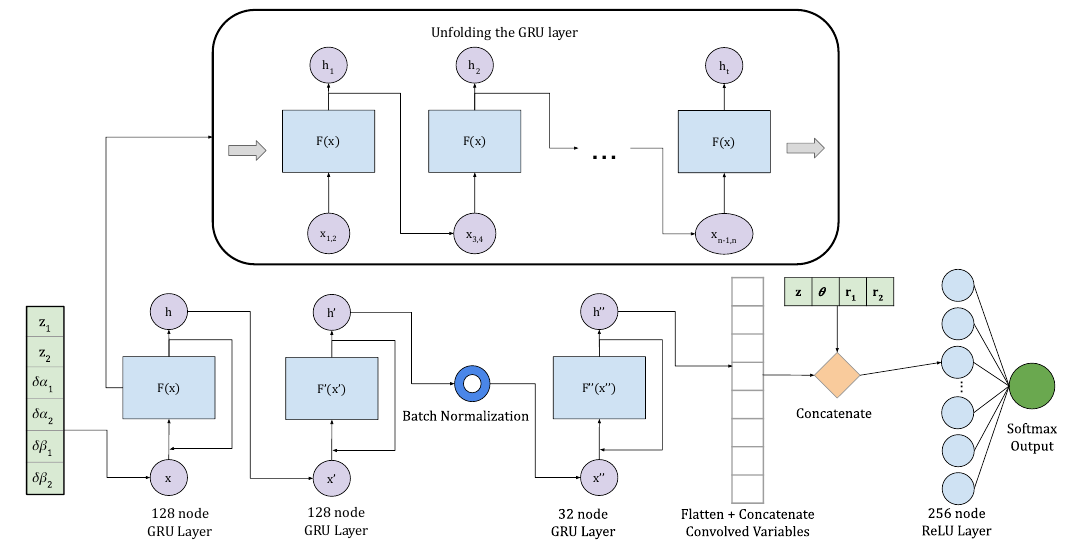
Figure 7. Diagram of RNN for classification of toy model particle lists. When used, XAUG variables are concatenated to the processed outputs immediately before the final dense